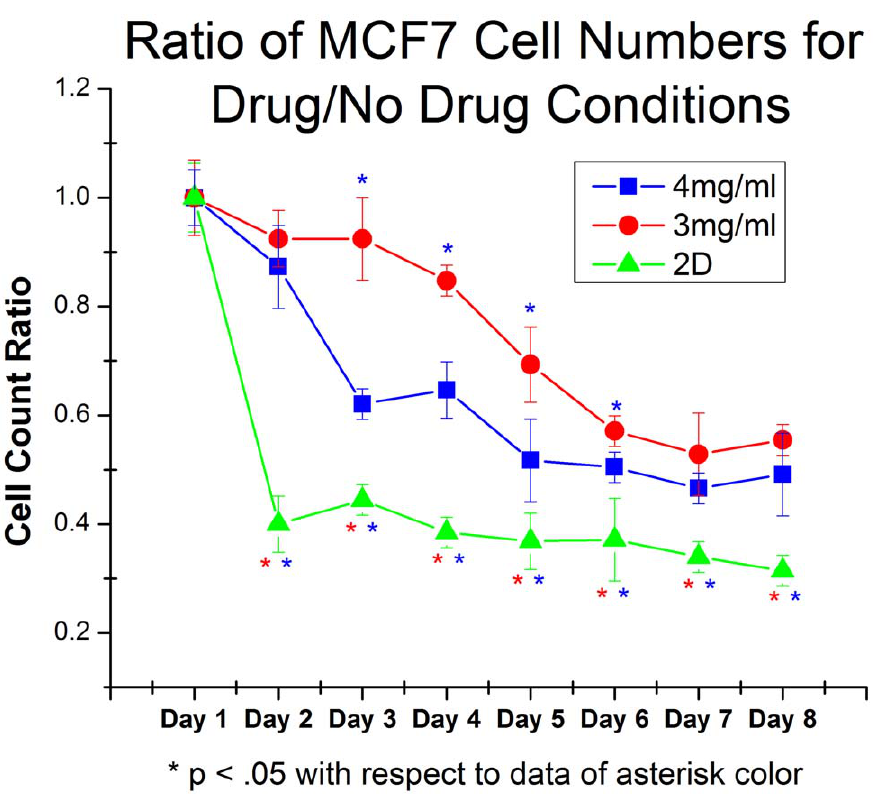
Figure 9. Ratio of MCF7 cell number in samples treated with PI103 to samples left untreated. Data here is presented as a ratio of cell count in drug treated sample to untreated controls. As in figure 8, data is presented as a ratio of cell counts in the drug treated and untreated samples. Similar to U2OS cells, MCF7 cell survived very well in 4 mg/ml collagen gels when compared to cells in 2D. Unlike U2OS cells, MCF7 cells in 3 mg/ml collagen gels survived equally as well as cells in stiffer gels. Both of these conditions yielded cells with higher drug resistance than cells grown in monolayer. Although this behavior is not as complex as observed in U2OS cells, it highlights the difference between 2D and 3D culture